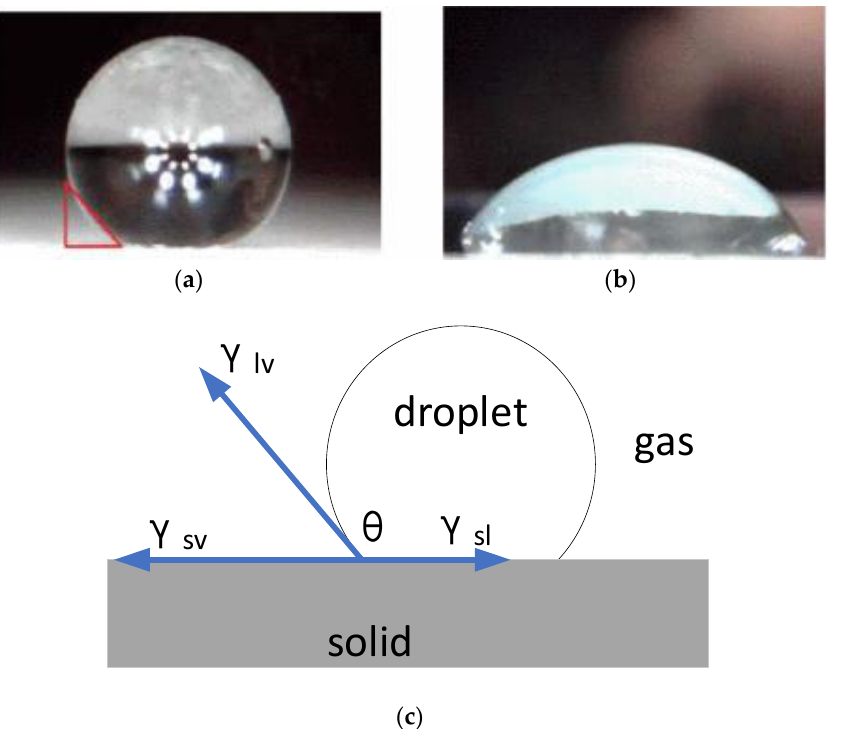
Figure 21. Droplets on the surface. ( a ) Droplet on the hydrophobicity. ( b ) Droplet on the hydrophilic. ( c ) Model analysis of water droplets on solid surfaces [47].